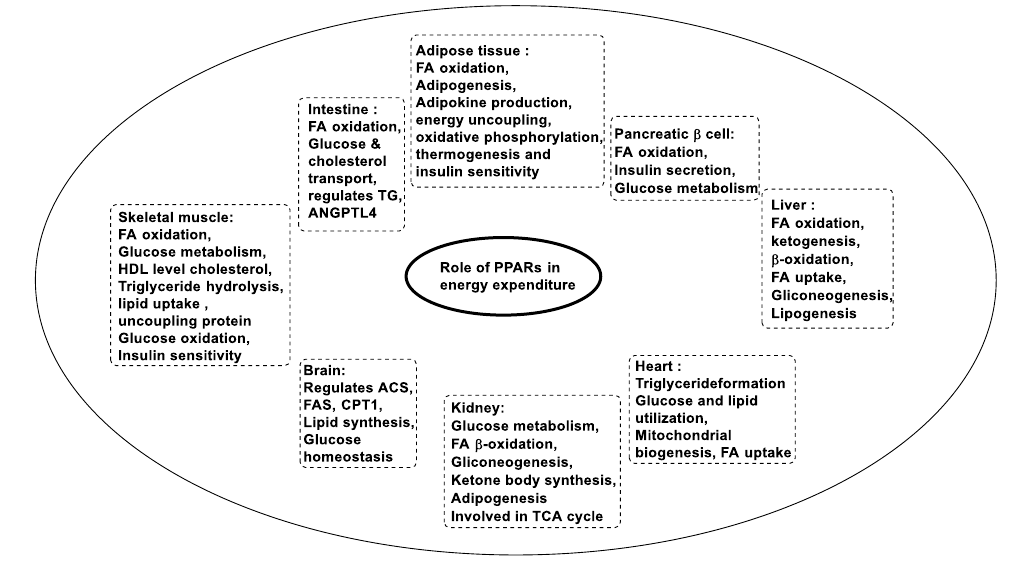
Figure 4. Functions of PPARs. Table 1. Various patents on Peroxisome proliferator-activated